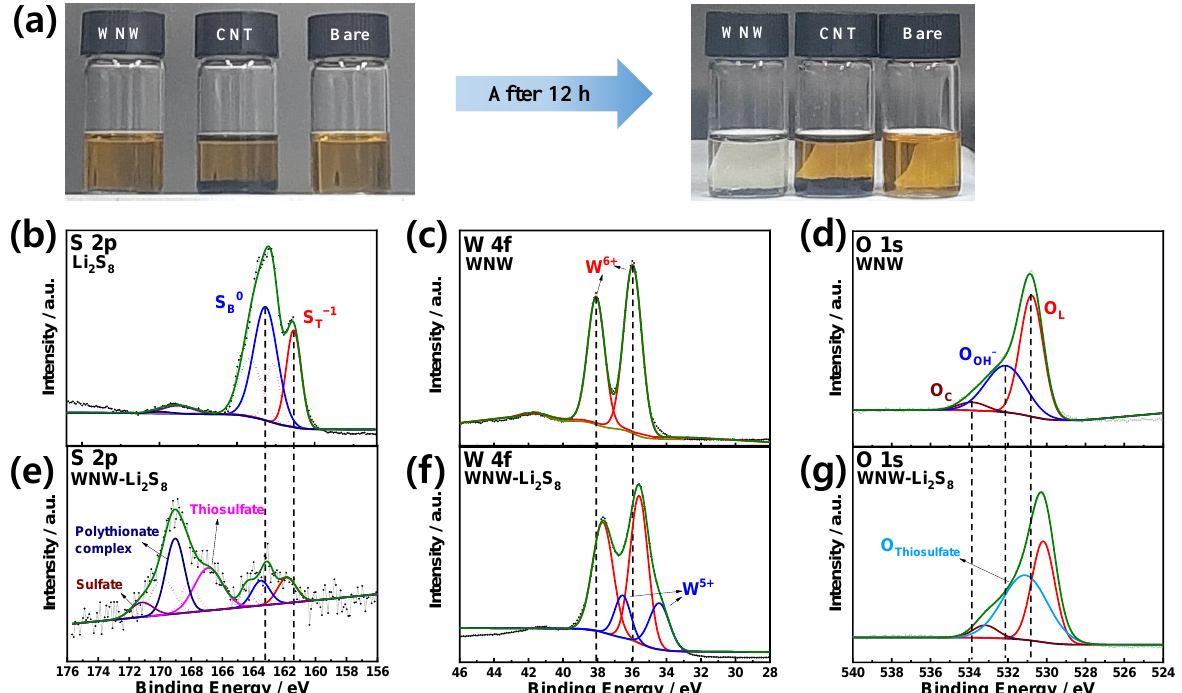
Figure 2. ( a ) Photographs of lithium polysulfide (0.0025 M Li 2 S 8 2 mL) electrolyte adsorption test. ( b ) XPS S 2p spectrum of Li 2 S 8 . XPS spectra of WNW: ( c ) W 4f and ( d ) O 1s. XPS spectra of WNW after Li 2 S 8 adsorption test ( e ) S 2p, ( f ) W 4f, and ( g ) O 1s.